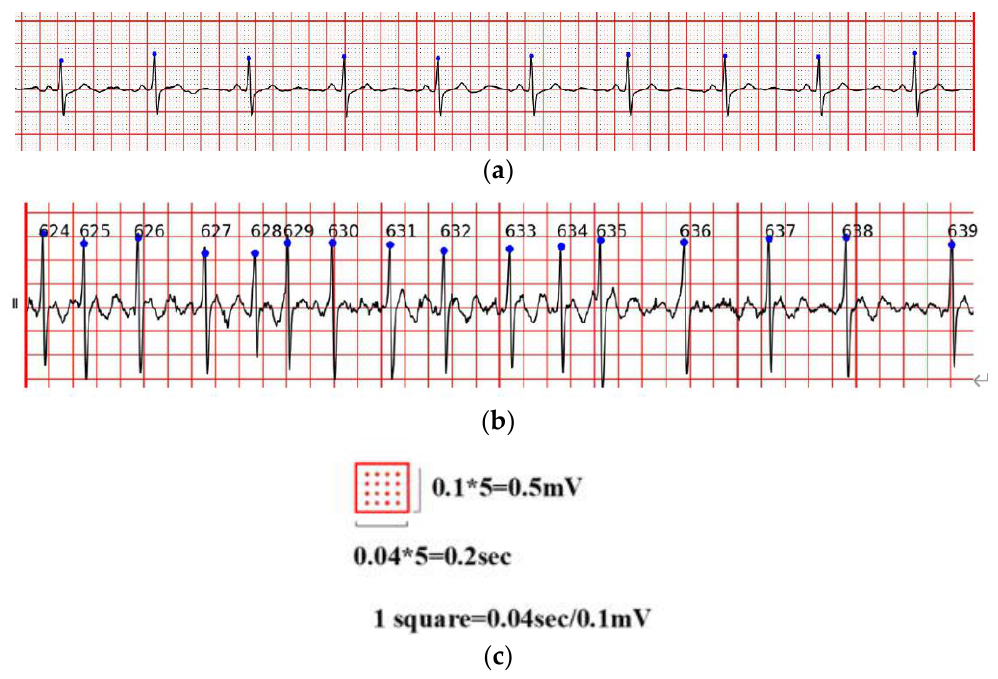
Figure 2. ( a ) Normal ECG, ( b ) atrial fibrillation ECG; ( c ) is the scales of ( a ) and ( b